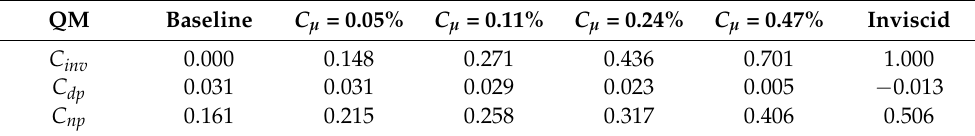
Table 1. Variation of quality metrics (QM) with momentum coefficient for fluidic oscillators. QM Baseline C µ = 0.05% C µ = 0.11% C µ = 0.24% C µ = 0.47% Inviscid C